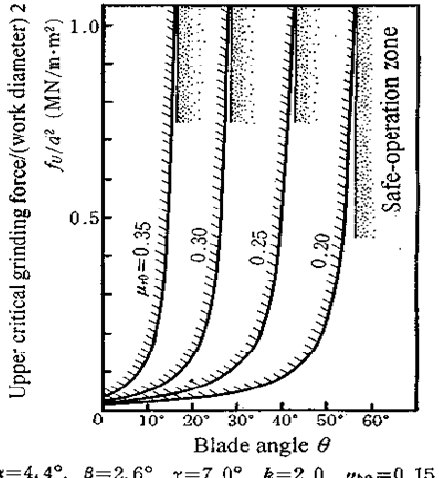
Figure 6. Upper limit tangential grinding force.